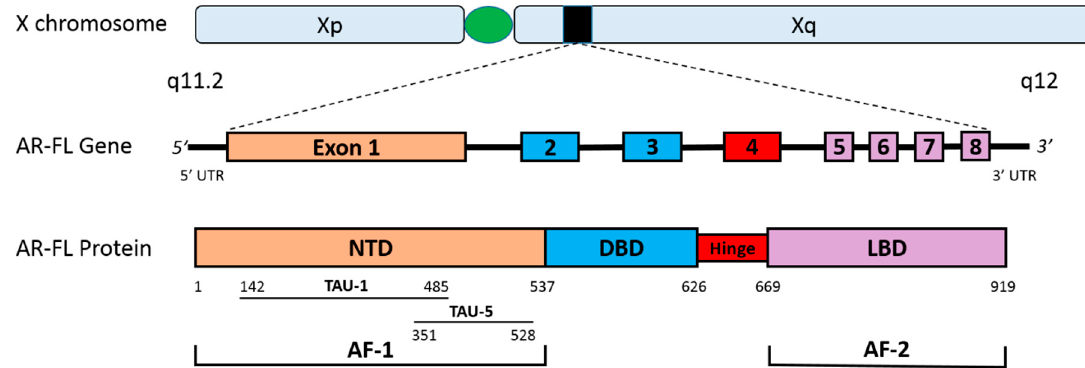
Figure 1. The human androgen receptor gene and protein. This figure depicts the gene and protein structures for the AR-FL. The AR is located on the X chromosome (Xq11.2) and is comprised of eight exons. AR-FL contains the NTD (encoded by exon 1), the DBD (encoded by exons 2–3), the hinge region (encoded by exon 4) and the LBD (encoded by exons 5–8). The strong transcriptional activity in the NTD can be attributed to the AF-1, while the LBD contains the weaker AF-2. Two major transactivation units are present in the AF-1: TAU-1 and TAU-5. Abbreviations: AF-1, activation function 1; AF-2, activation function 2; AR-FL, androgen receptor full length; DBD, DNA-binding domain; LBD, ligand-binding domain; NTD, N-terminal transactivation domain; TAU-1, transactivation unit 1; TAU-5, transactivation unit 5; UTR, untranslated region.